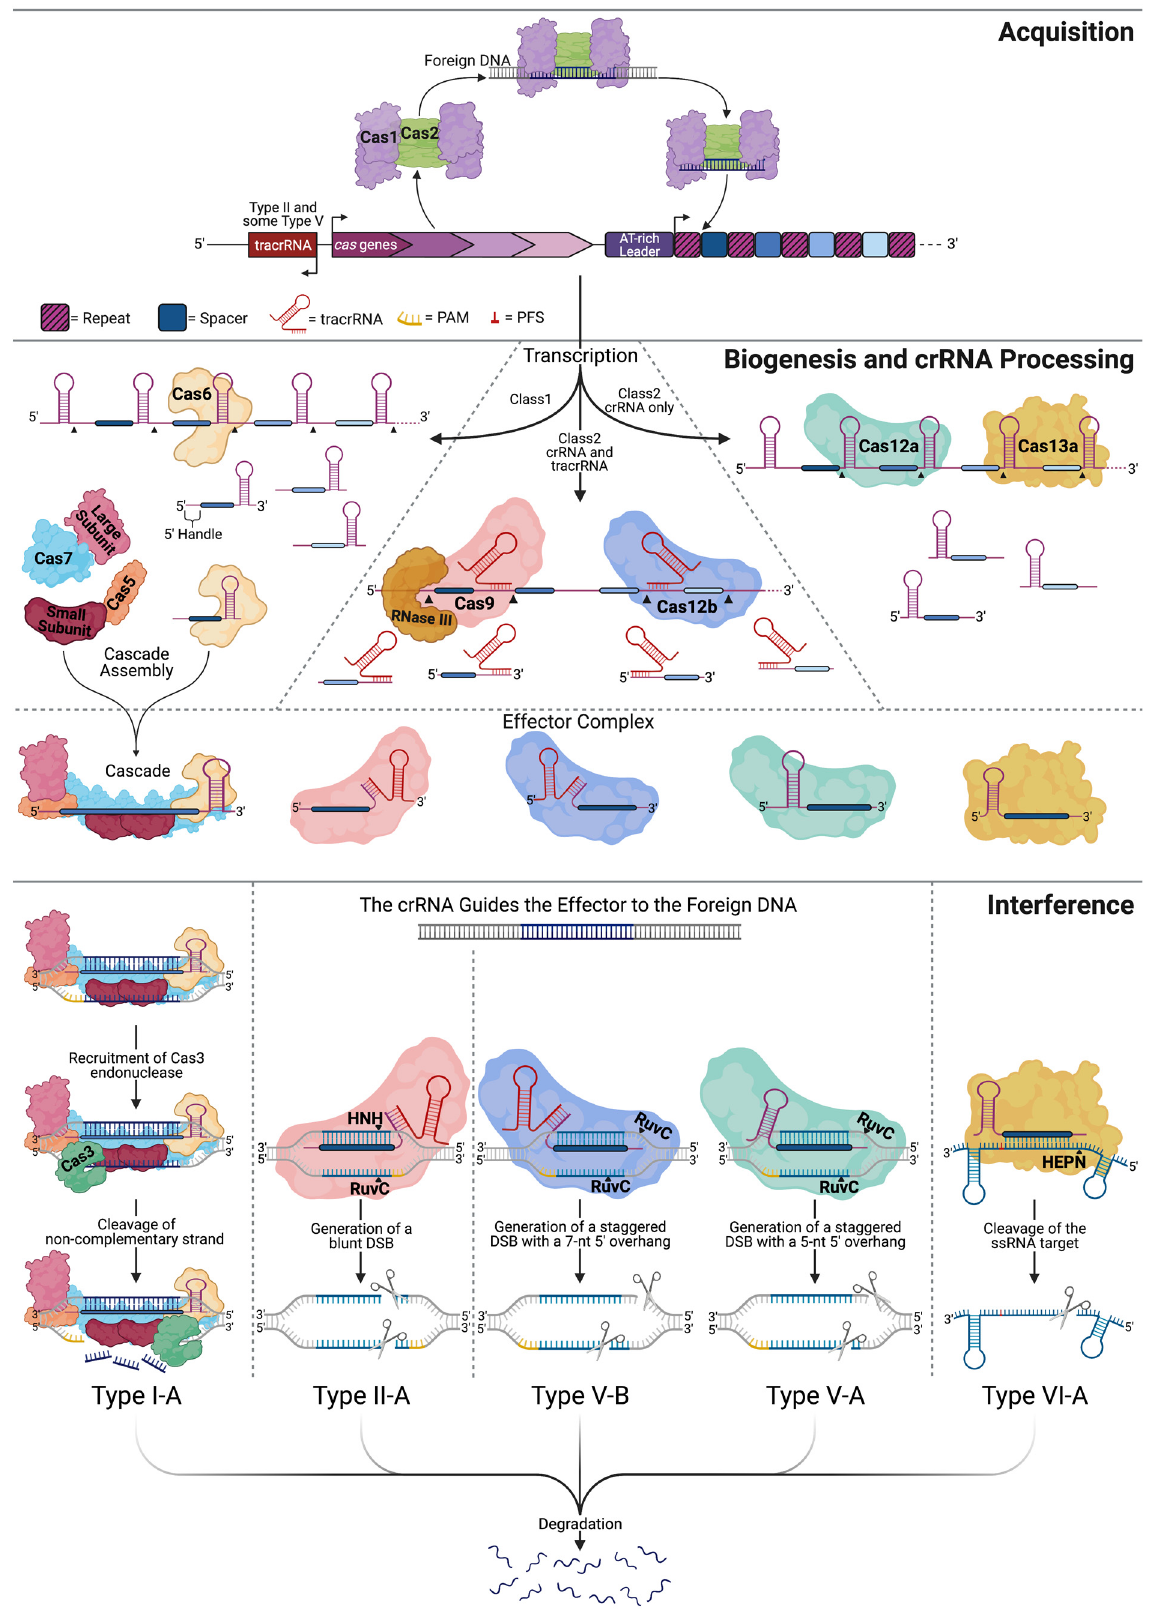
Figure 1. Comparison between Class I and Class II CRISPR immunity pathways. CRISPR immunity takes place in three general steps: acquisition, biogenesis, and interference. Type I-A, II-A, V-B, V-A, and VI-A are examples to illustrate some of the differences between each CRISPR type. In the majority of CRISPR systems, the acquisition is carried out by the Cas1-Cas2 complex, which locates a protospacer within the foreign DNA, excises it, and incorporates the new spacer into the